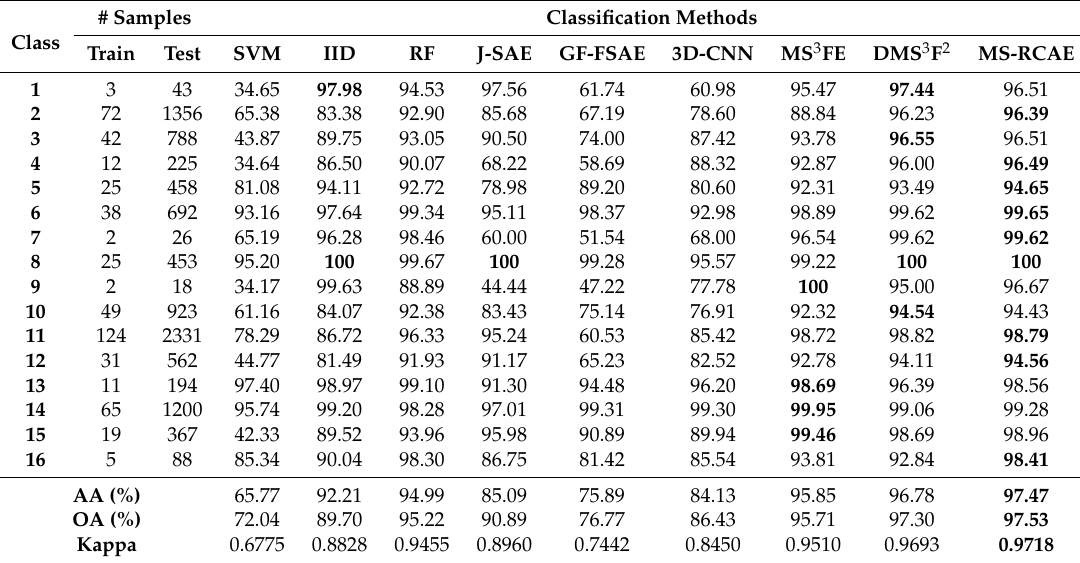
Table 1. Classification accuracies of the Indian Pines dataset obtained by each comparison methods. The best results are highlighted in bold font.